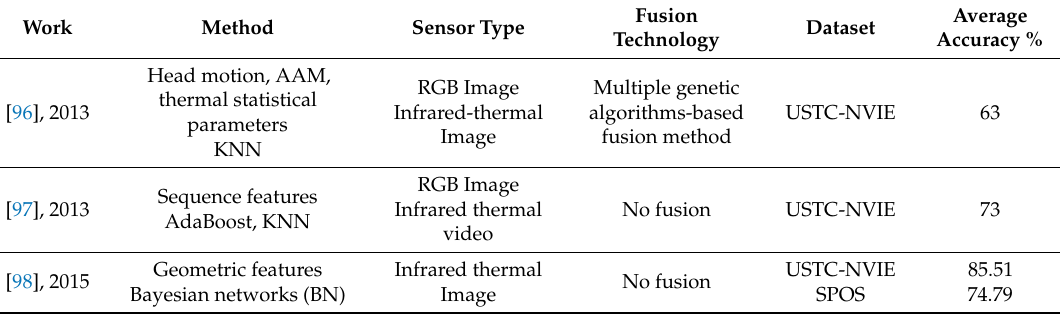
Table 5. Existing FER systems using target-focused sensors.